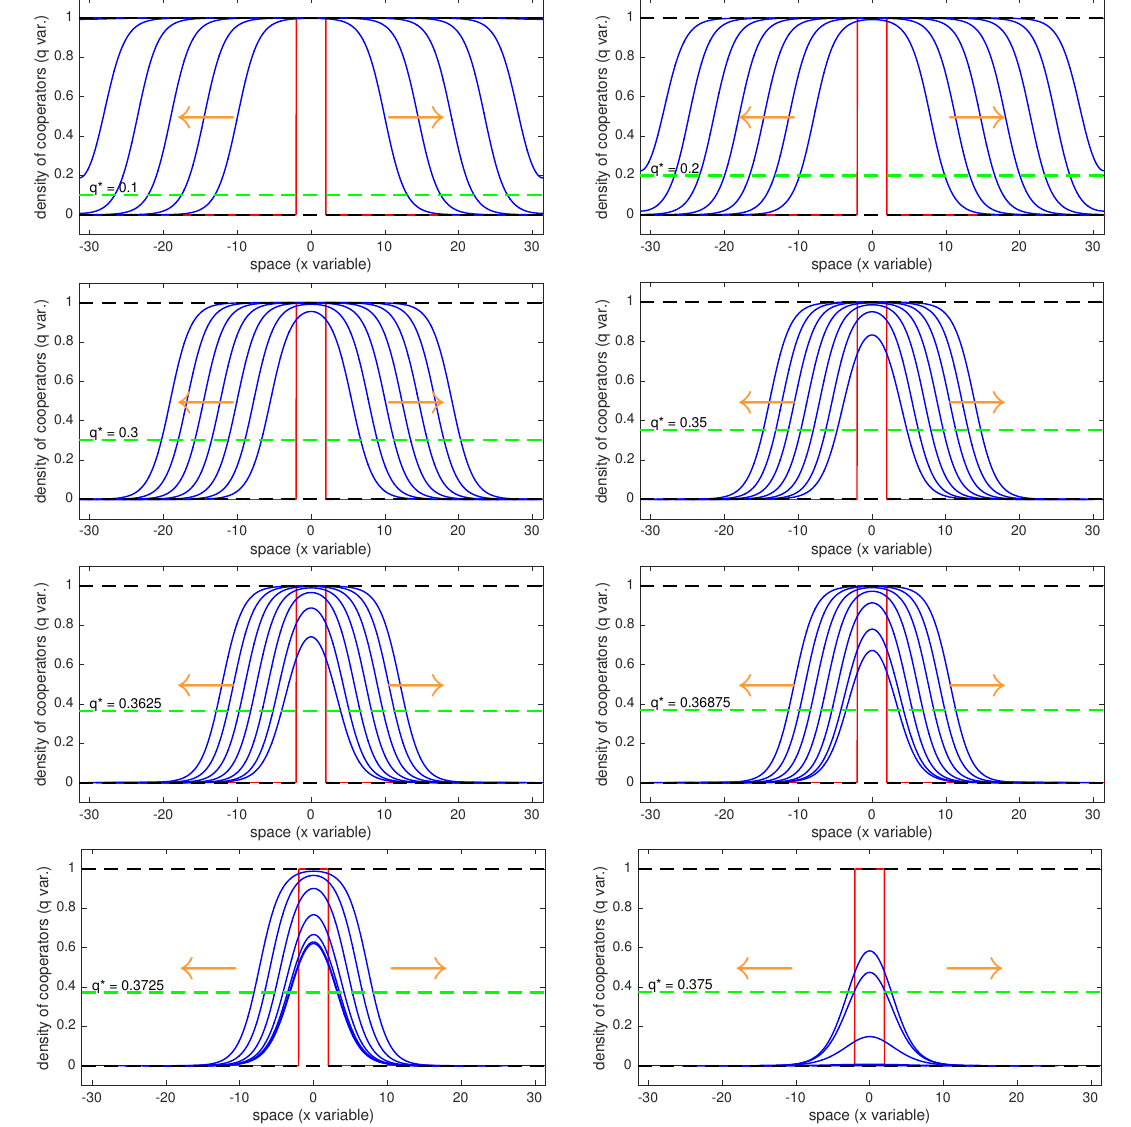
Figure A3. Starting from the left up going to the right and then to the following row, the values chosen here are: q ∗ = 0.1; q ∗ = 0.2; q ∗ = 0.3; q ∗ = 0.35; q ∗ = 0.3625; q ∗ = 0.368975; q ∗ = 0.3725; q ∗ = 0.375. We can see that for the last simulation, q ∗ = 0.375, the initial datum we have chosen has not a big enough domain to